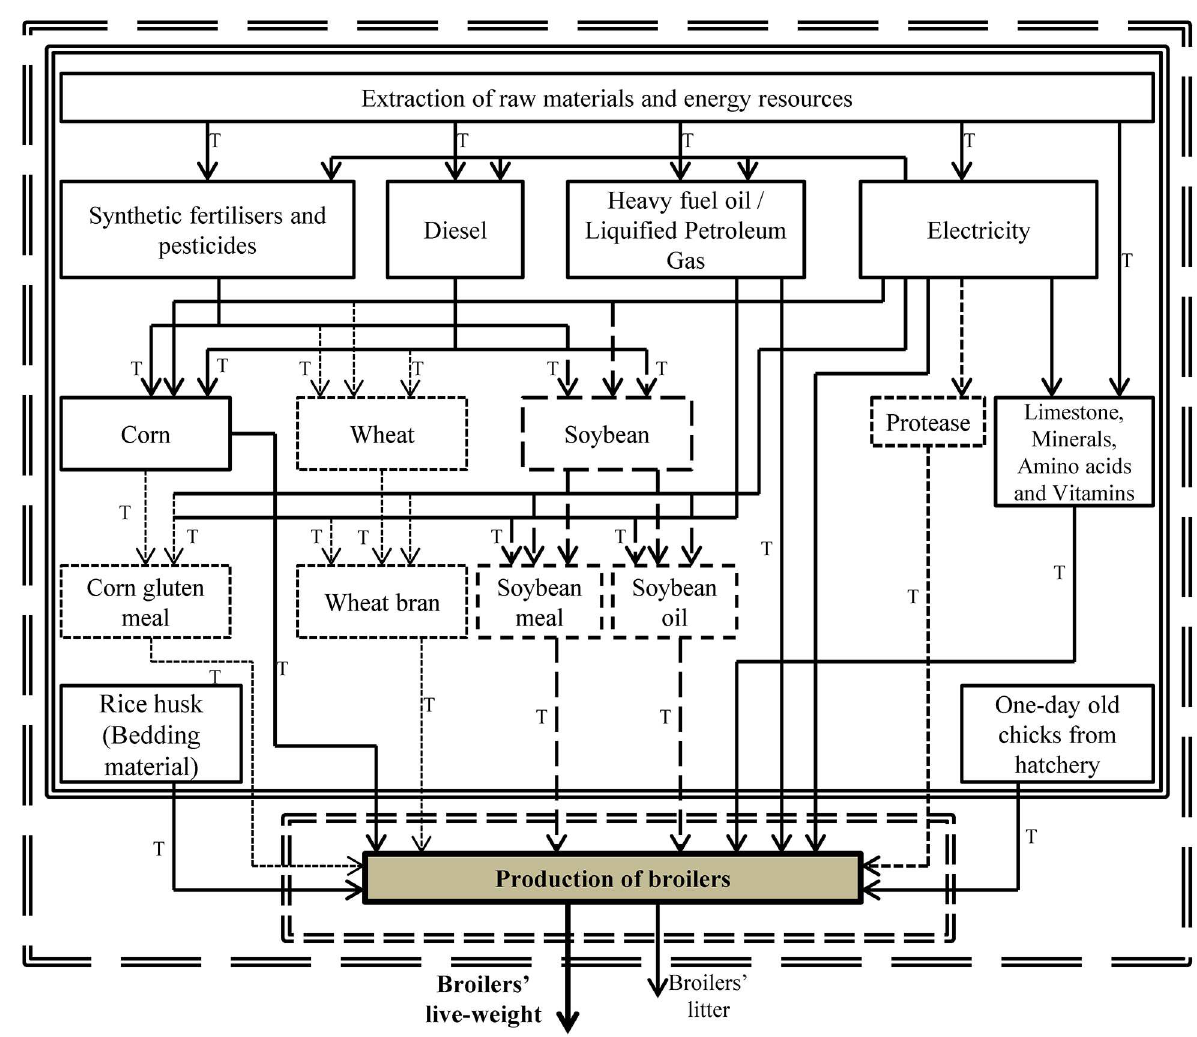
Fig 1. Simplified flowchart indicating the systemboundaries for the examined partial life cycle of the production of 1 kg of broilers’ LW. Double boldlong-dashedline: system boundaries;doublebold short-dashed line: foregroundsystem; doublebold continuous line: background system; single bold continuous lines and arrows: processes taking place in all three systems; single bold long-dashed lines and arrows: processes taking place in the ‘Control’and ‘Soy-Prot’ systems; single bold short-dashed lines and arrows: processestaking place in the ‘Soy-Prot’ and ‘Gluten-Prot’systems; singleregularshort-dashedlines and arrows: processes taking place only in the ‘Gluten-Prot’system; T: Transport processes.